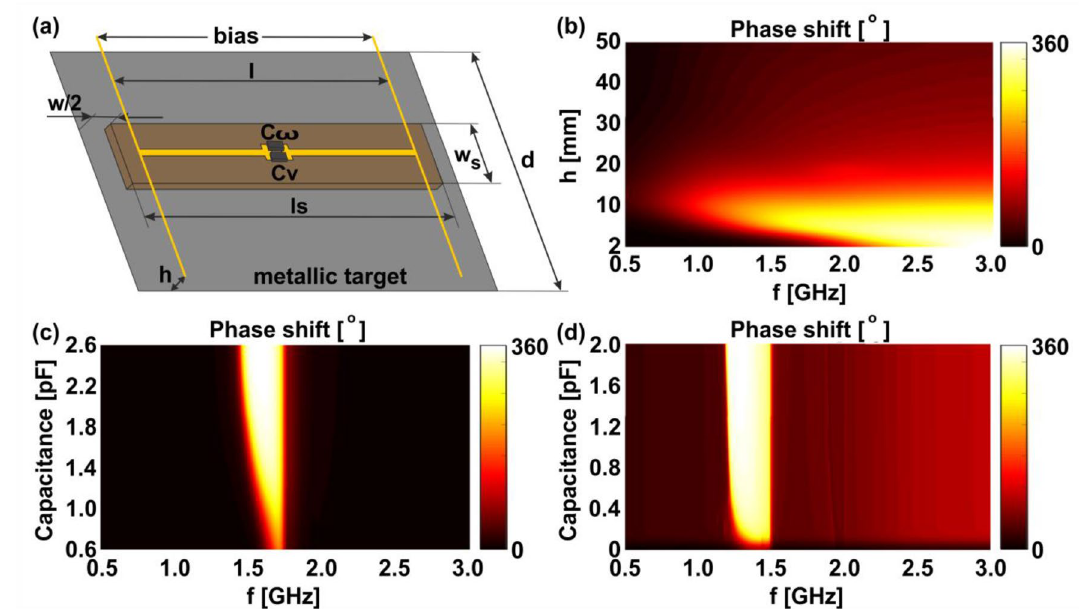
Figure 3. Numerical modelling of the metasurface Doppler cloak, constructed from a 9 × 9 array of dipoles on a substrate above a metal ground plane which represents the target to be concealed. ( a ) A single unit cell containing the dipole, varactor and biasing network. ( b ) Relative phase shift as a function of distance h between the dipole and metallic target, as well as the frequency of the incident radiation. ( c ) The phase shift as a function of varactor capacitance and incident frequency for dielectric width h = 6 mm ( d ) Improving the operational bandwidth—the phase shift from the metasurface after adding an additional frequency dependant capacitor C ω , shown on ( a